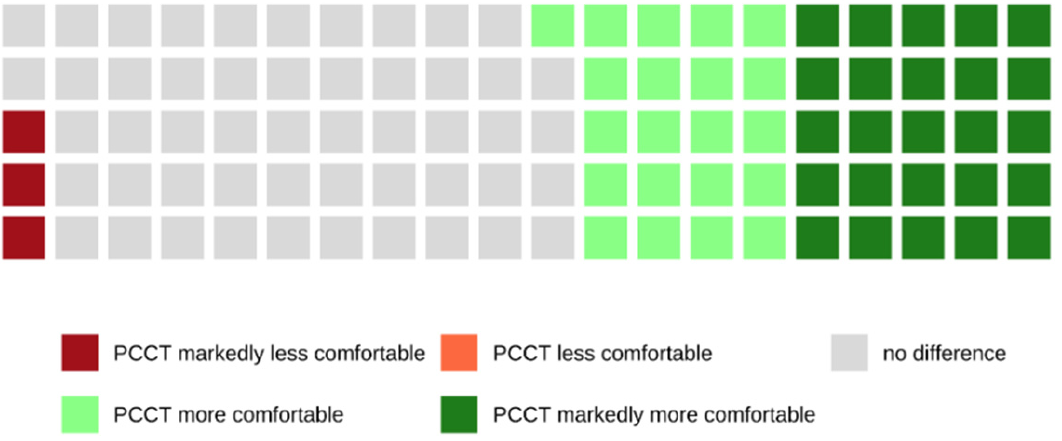
Figure 6. Waffle chart showing the comparison of both CT scanners in terms of speed and comfort of the CT table. Most patients (50.8%) did not notice a difference between both scanners, but 46.0% of the patients perceived the PCCT as more or markedly more comfortable.